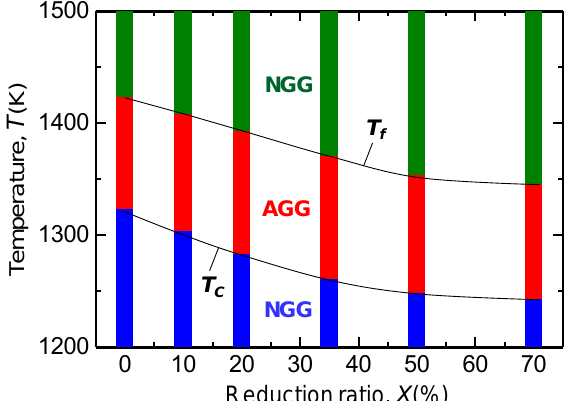
Figure 4. Austenite grain growth behavior against annealing temperatures in the specimens deformed at various reduction ratios.